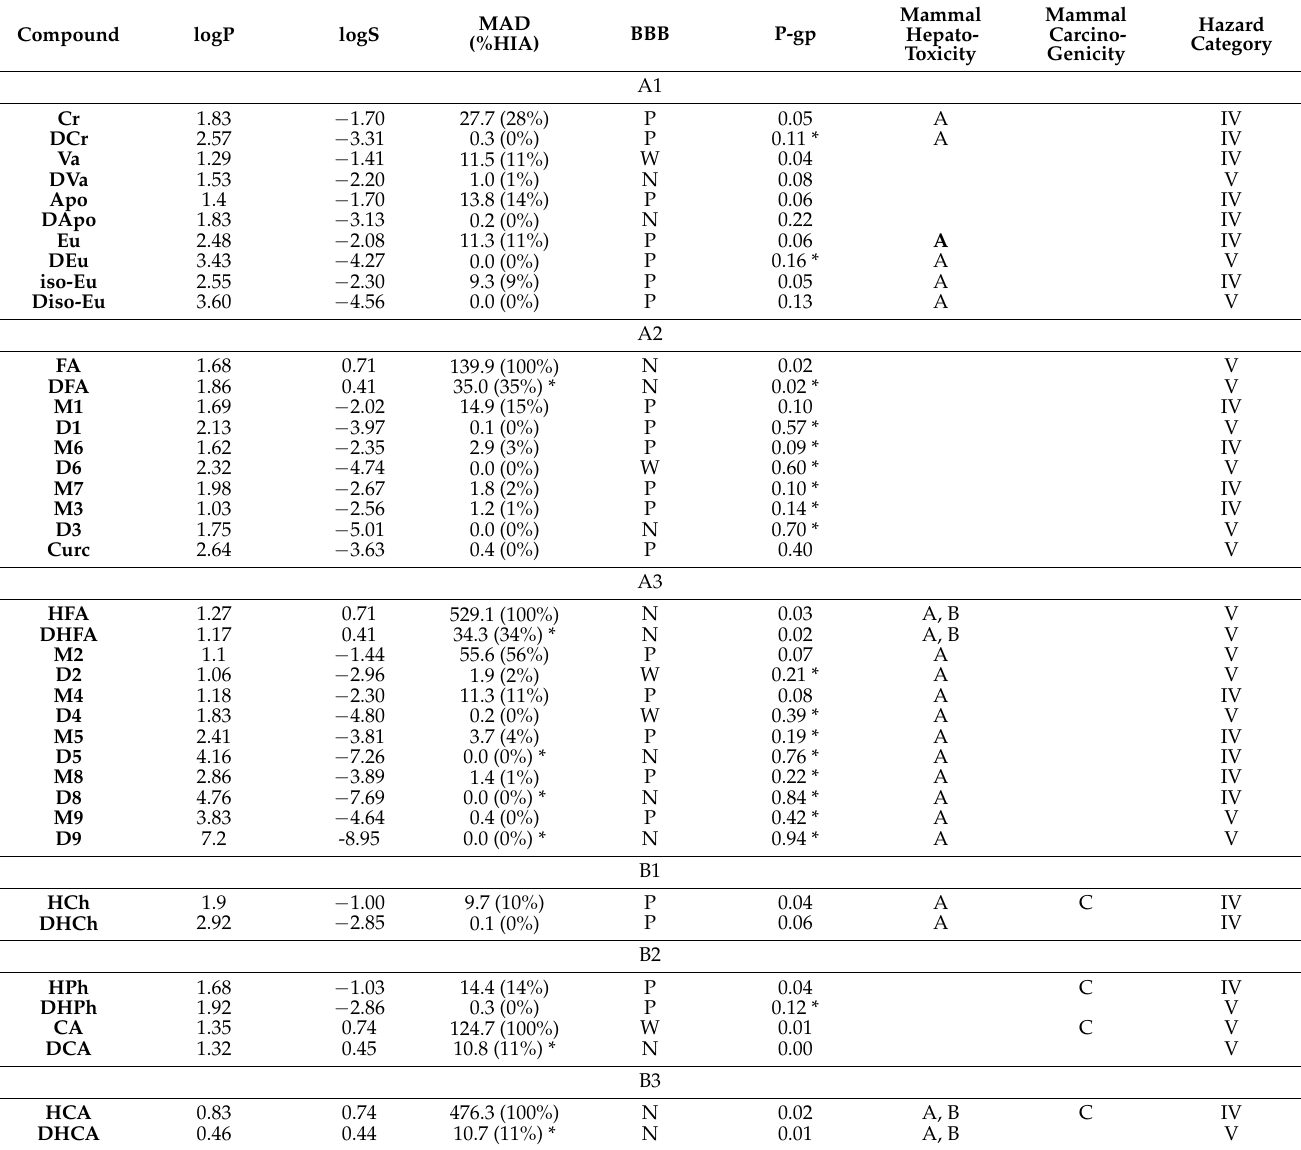
Table 5. In silico predictions of important ADME/Tox properties of the investigated compounds.